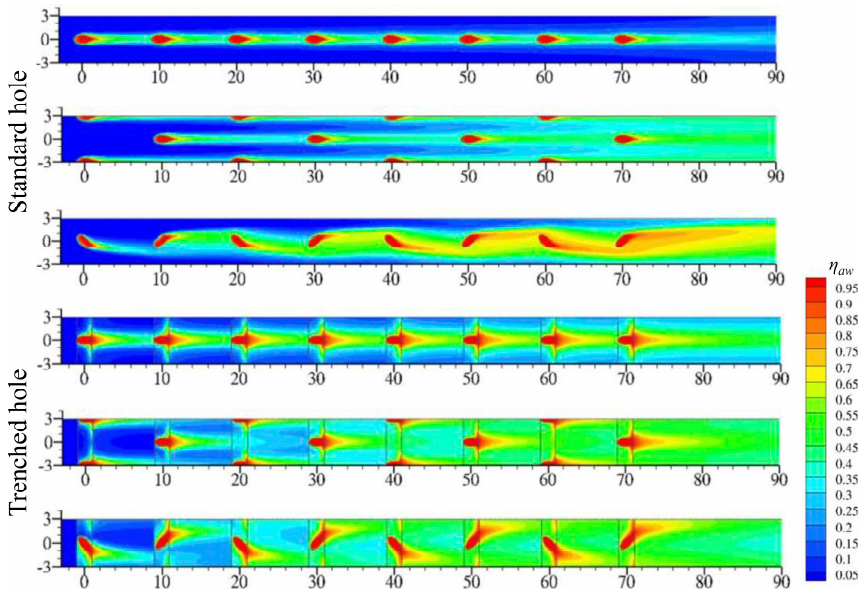
Figure 11. Adiabatic cooling efficiency for various effusion cooling configurations. Adapted with permission from [88]. Licensed under a Creative Commons Attribution (CC BY) license.